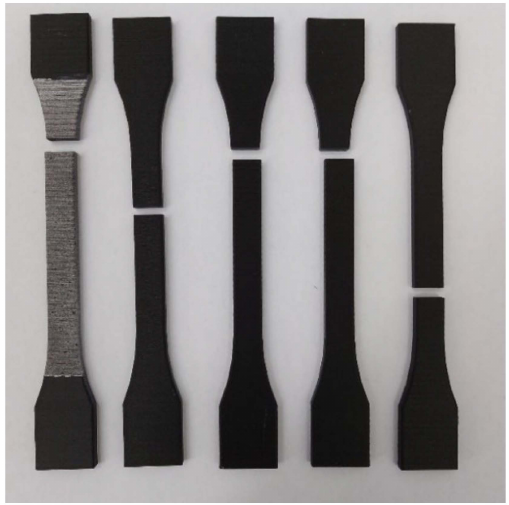
Figure 16. Failure mode of the XZ2 specimens.